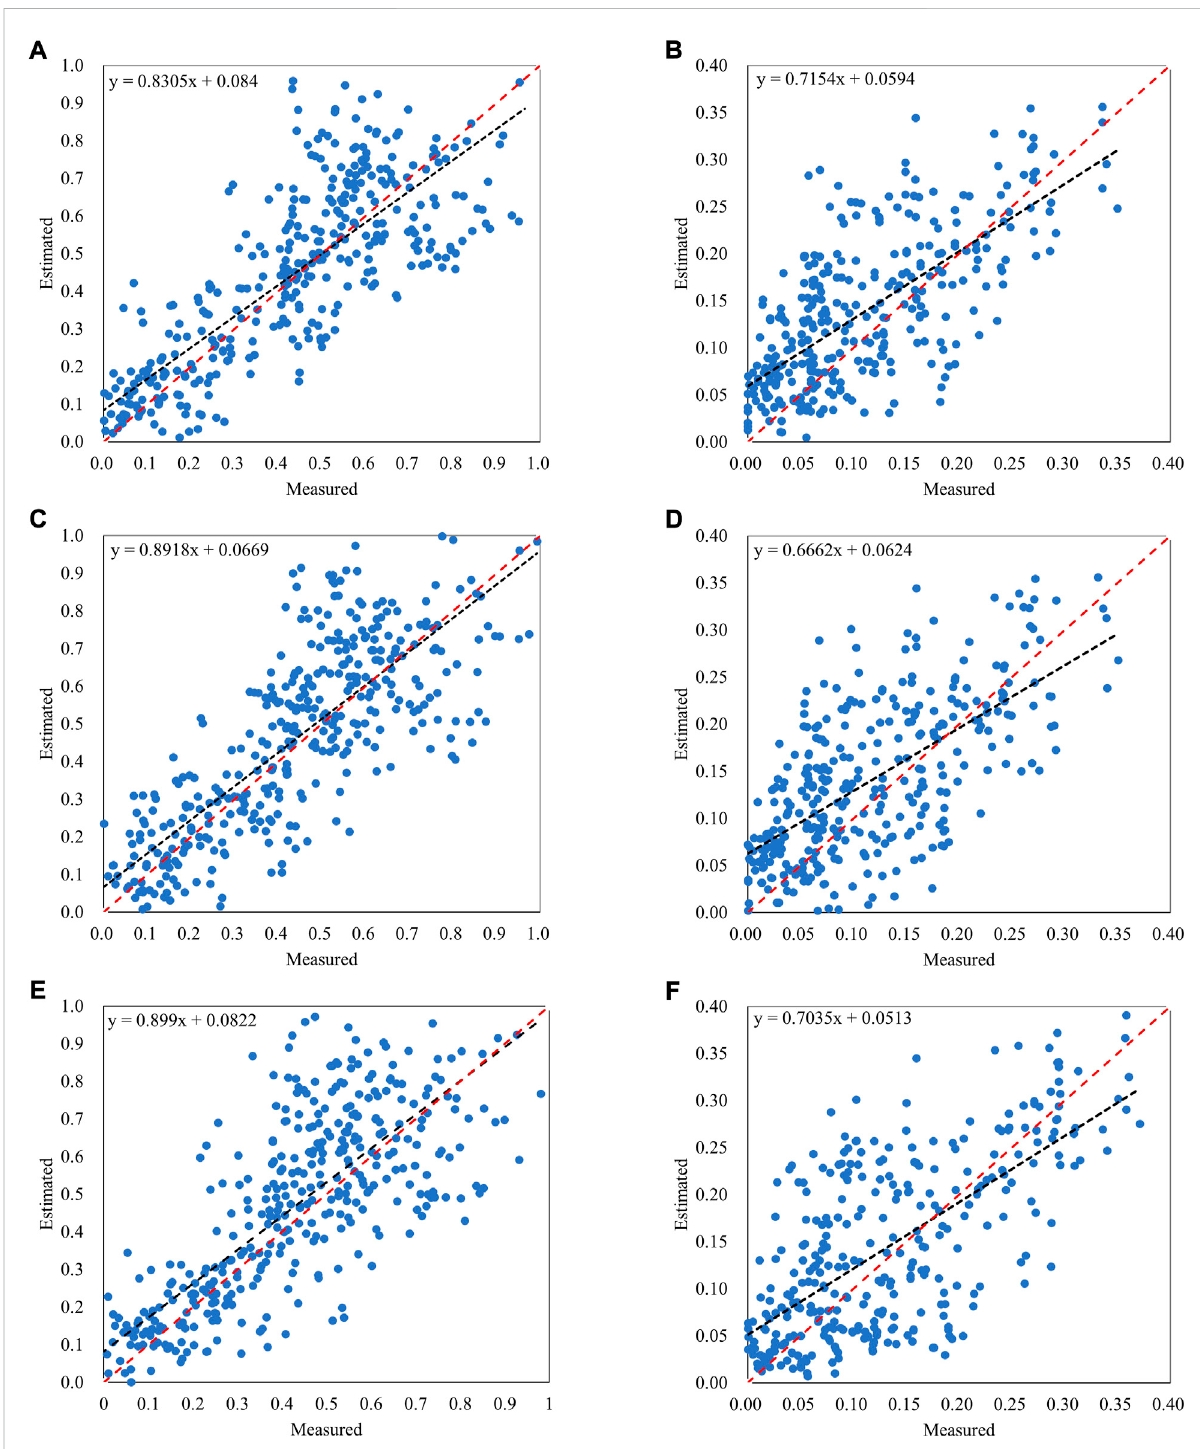
FIGURE 8 f VC andf BR estimationaccuracyvalidation against fi eld samples. (A) f VC of Sentinel-2, (B) f BR of Sentinel-2, (C) f VC ofGF-6, (D) f BR of GF-6, (E) f VC of Landsat 8, (F) f BR of Landsat